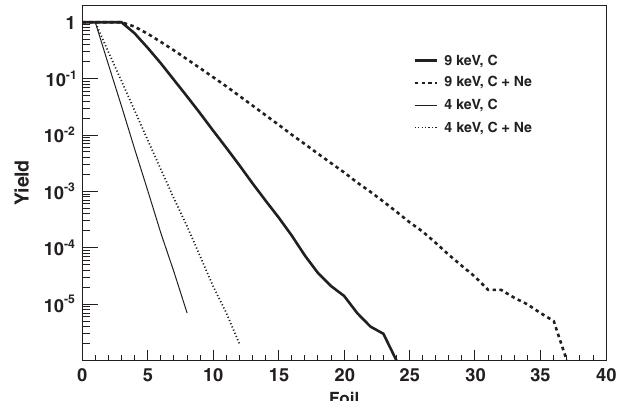
FIG. 7. Yield of (cid:1) þ in carbon-foil frictional-cooling schemes as a function of number of foils traversed after reaching T both naked foils and frozen-neon-coated